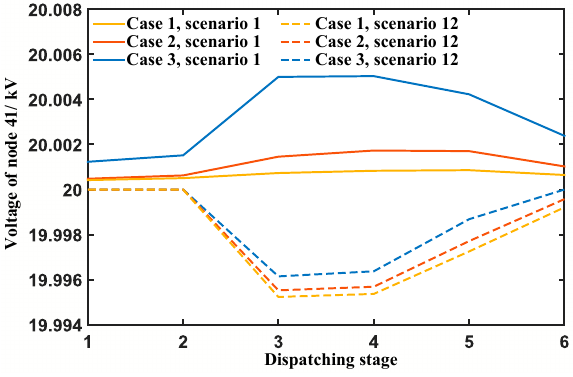
Figure 8. Voltage of node 41 considering di ff erent abandonment rates.